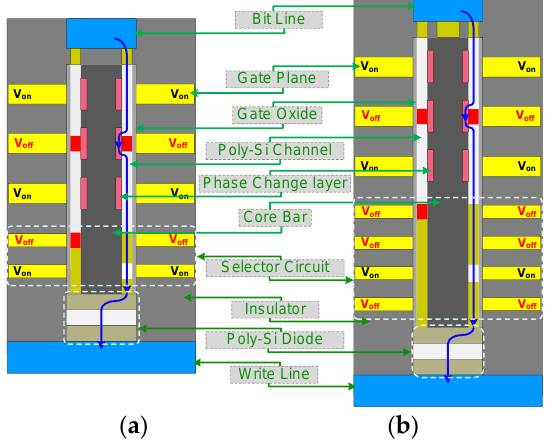
Figure 4. Operation sequences of the proposed PCM arrays: ( a ) diploid unit array; ( b ) four-fold unit